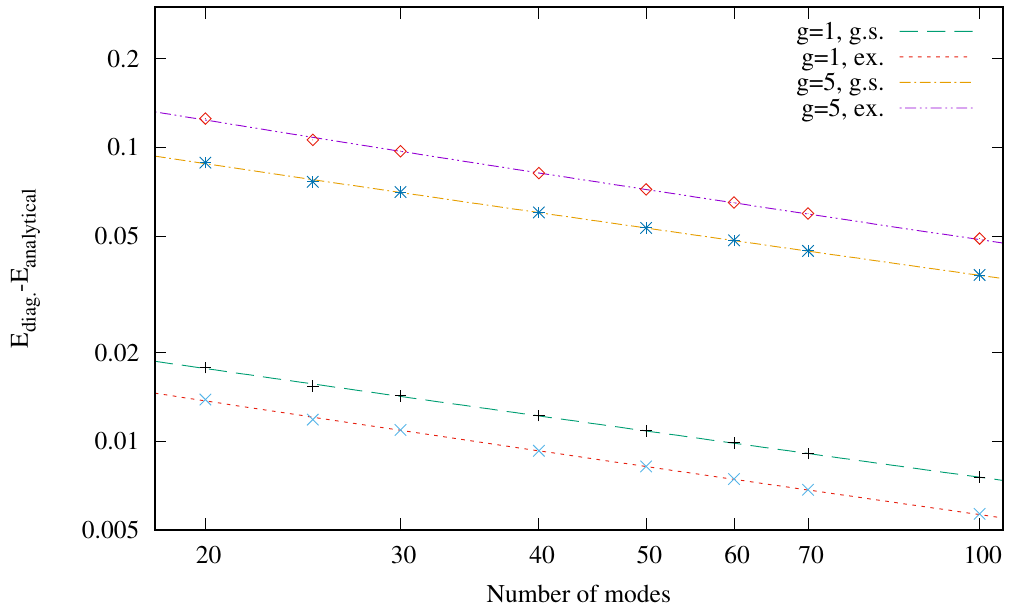
Figure 2. Differences between the numerical results and the exact ones as a function of the number of single particle modes, for two values of the interaction strength, g = 1 and g = 5, for the ground (g.s) and first excited (ex.) state. The lines are fits of the type C 1 / N 1/2 Both axes are in a logarithmic